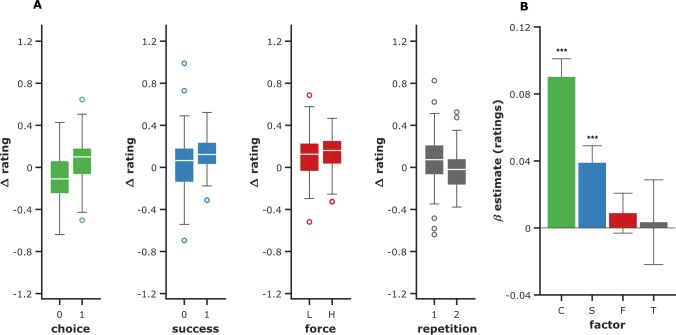
Influence of past actions on desirability ratings.(A) Left panels show the change in rating (R2-R1 and R3-R2 taken together) as a function of choice (0: unchosen, 1: chosen), success (0: unsuccessful, 1: successful), and exerted force (L: low, H: high, according to a median split). All trials were included to test the effect of choice, only accepted trials for the effect of success, and only successful trials for the effect of exerted force. The right most panel show the effect of task repetition (1 is R2-R1, 2 is R3-R2). White line: median, points are drawn as outliers if they are larger than Q3+1.5*(Q3-Q1) or smaller than Q1-1.5*(Q3-Q1), where Q1 and Q3 are the 25th and 75th percentiles, respectively. (B) Regression estimates corresponding to the choice (C), success (S), and force (F) factors, and to the intercept (T for time). Error bars represent inter-subject SEM. Stars and dots: * p<0.05; ** p<0.01; *** p<0.001.